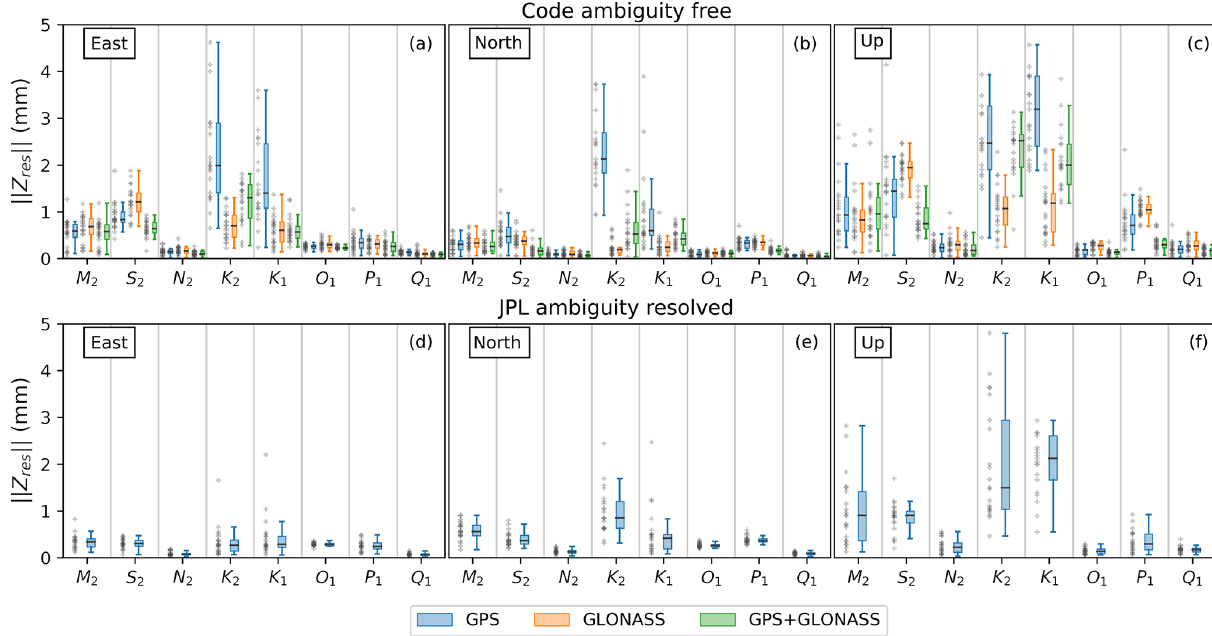
Figure 3. (cid:107) Z res (cid:107) per tidal constituent for east, north and up components (left, middle and right, respectively) relative to FES2014b_STW105d OTL values with centre-of-mass correction (CMC) for JPL solutions. Grey crosses to the left of each boxplot represent sites’ (cid:107) Z res (cid:107) values and are offset horizontally for clarity, while the horizontal line over each boxplot is a median of each constituent’s (cid:107) Z res (cid:107) . (a–c) (cid:107) Z res (cid:107) for GPS, GLONASS and GPS+GLONASS PPP solutions (blue, orange and green, respectively) computed using CODE products. (d–f) (cid:107) Z res (cid:107) of the GPS AR solution computed with JPL native products. The boxes show the interquartile range and the whiskers mark the limit of an additional ± 1 . 5 × IQR, with the median as a horizontal